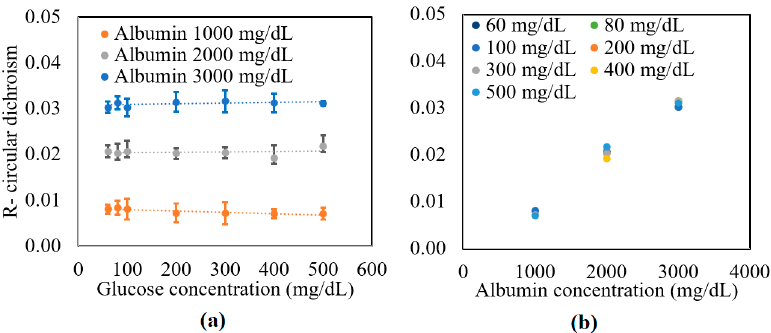
Figure 3. Experimental results for variation in R with: ( a ) glucose concentration as a function of albumin concentration, and ( b ) albumin concentration as a function of glucose concentration.